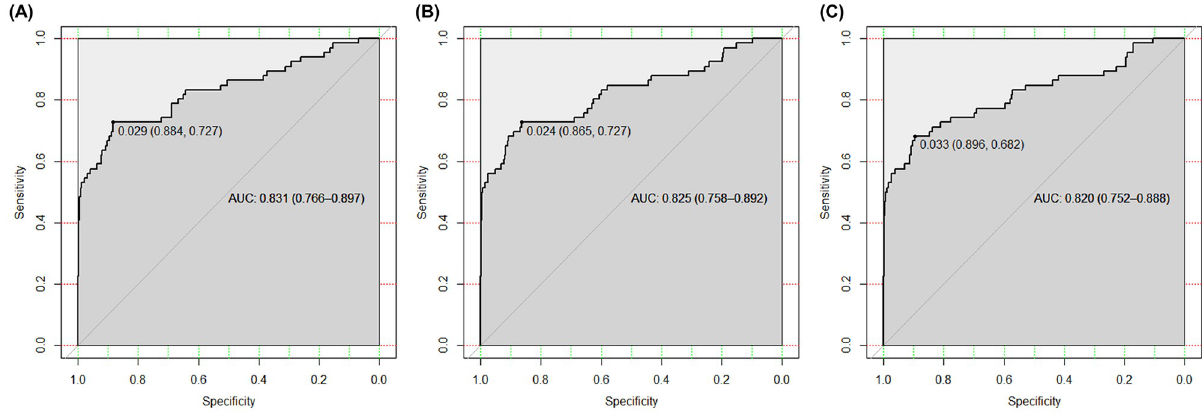
Fig 4. Comparison of receiver operating characteristic curve curves of 3 models. AUC: area under the receiver operating characteristic curve.